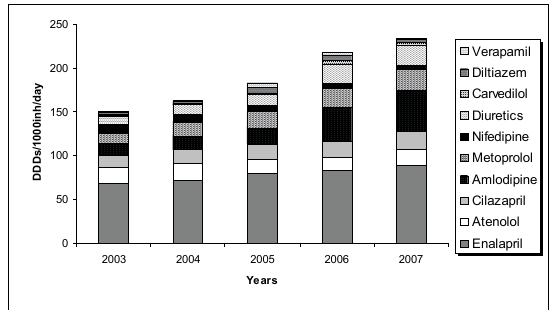
Figure 3. Trends in consumption of same antihypertensive drugs in Nis region